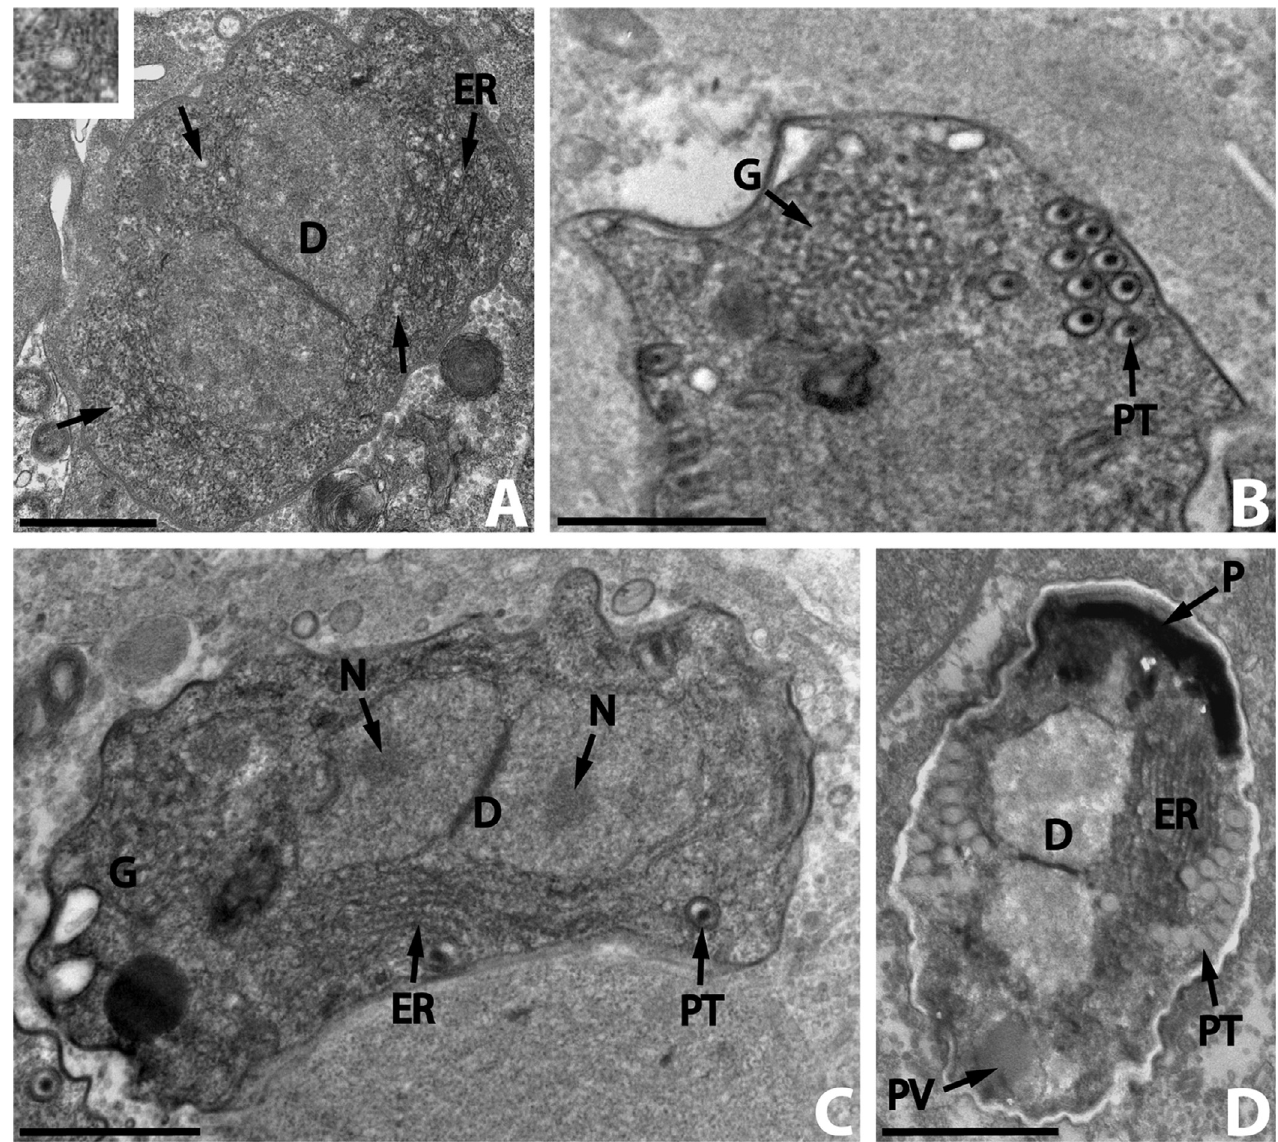
Figure 3. Nosema podocotyloidis n. sp. A. Young sporoblast showing numerous electron-lucent vesicles (arrows and insert) and the endoplasmic reticulum (ER). B. A part of the sporoblast showing the polar tube (PT) and the Golgi apparatus (G). C. Elongate sporoblast. Note the presence of the Golgi apparatus (G). D. Immature spore with 12 coils of polar tube. D: diplokaryon; ER: endoplasmic reticulum; N: nucleolus; P: polaroplast; PT: polar tube; PV: posterior vacuole. Scale Bars: A, B, C and D, 1 l